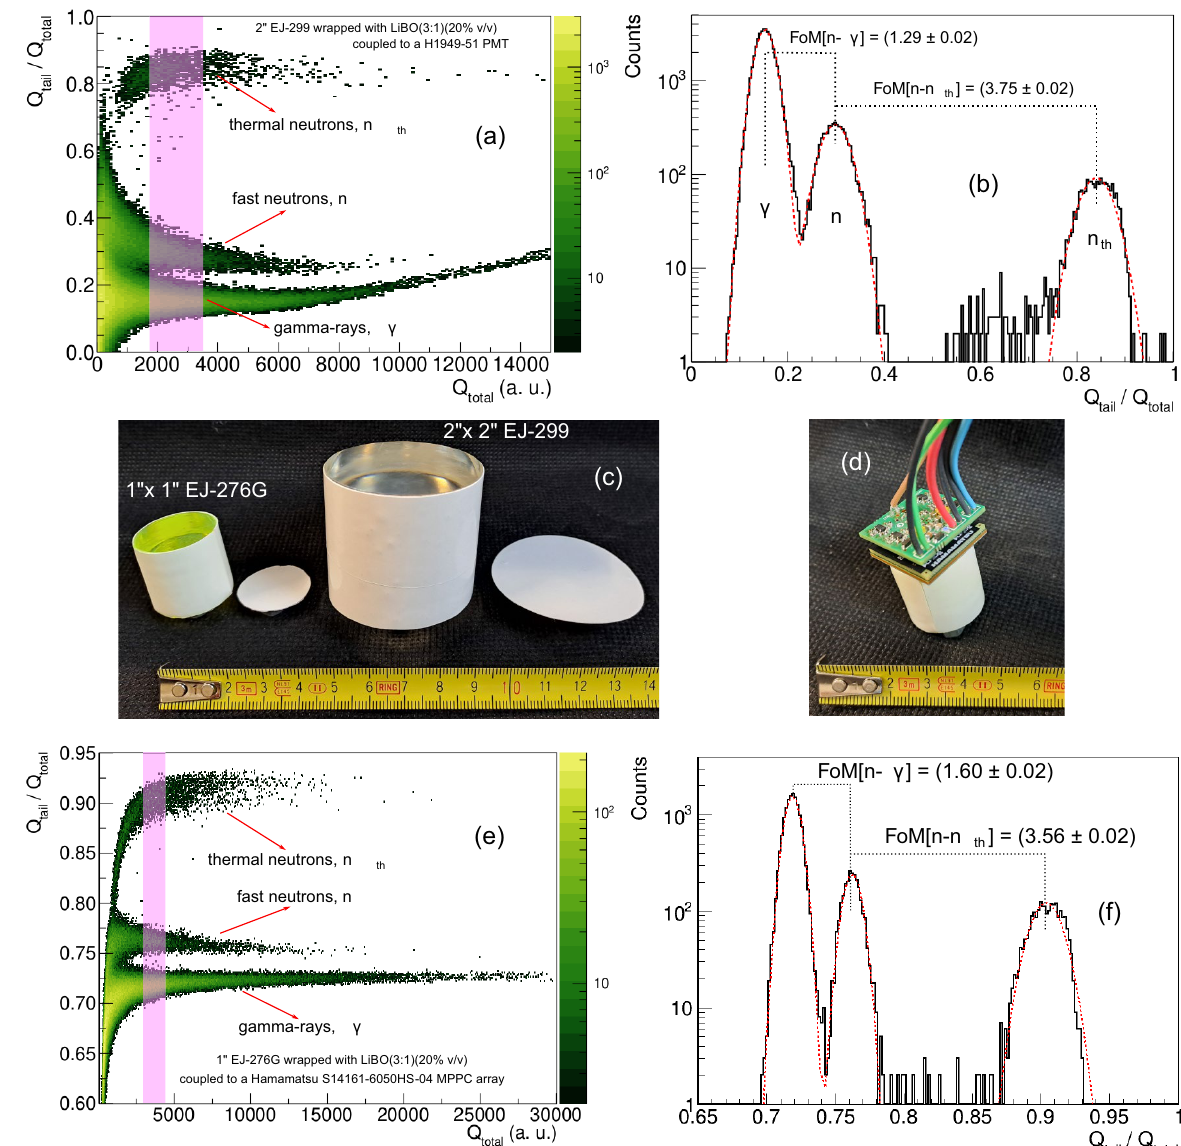
Figure 10. ( a ) 2D-PSD and ( b ) 1D-PSD plots of the ZnS:LiBO (3:1) (20% v/v)/PDMS-based detector covering the curved part and the top surface of EJ-299 plastic scintillator cylinder using a moderated 252 Cf source. ( c ) Picture of the hybrid assemblies 1 ′′ × 1 ′′ EJ-276G and 2 ′′ × 2 ′′ EJ-299 wrapped with the LiBO-based scintillator. ( d ) Picture of the EJ-276G/LiBO hybrid detector coupled to a Hamamatsu S14161-6050HS-04 MPPC array. ( e , f ) ( e ) 2D-PSD and ( f ) 1D-PSD plots of the assembly using a moderated 252 Cf